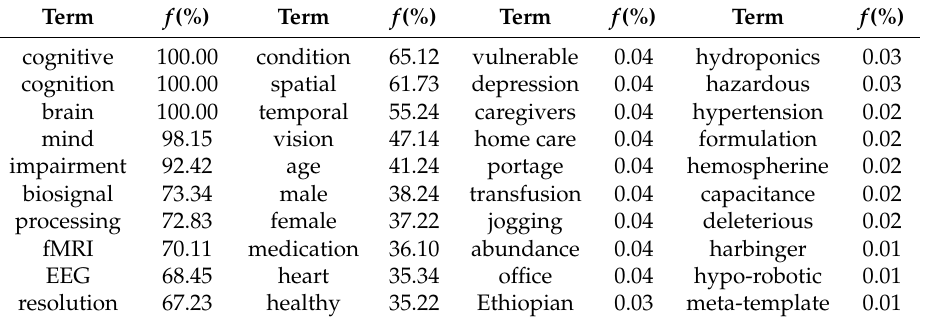
Table 11. Collection terms (frequency f as a percentage).